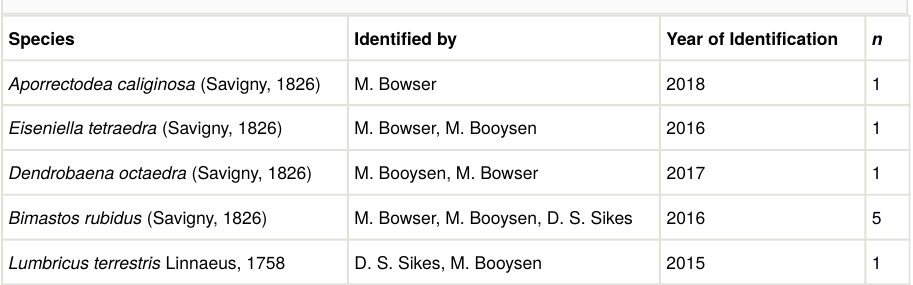
Earthworm (Lumbricidae) records in Interior Alaska as of May 4, 2018. Year column indicates the earliest year of identi fi cation to species of Interior Alaska specimens; n indicates the number of Interior Alaska sites known for each species.